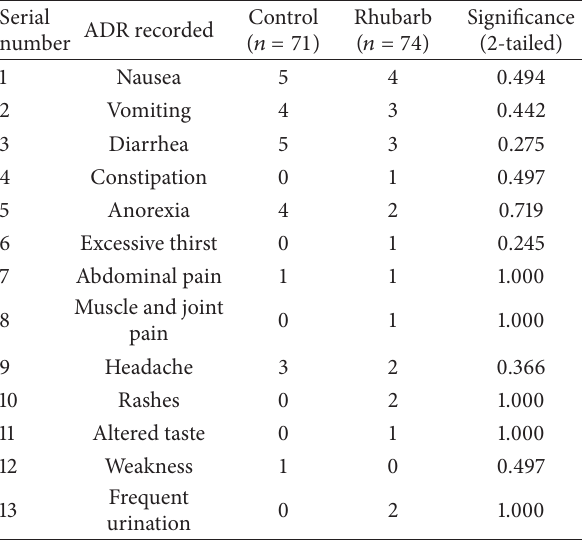
Table 3: Comparison of adverse drug reactions (ADRs) between control and Rhubarb